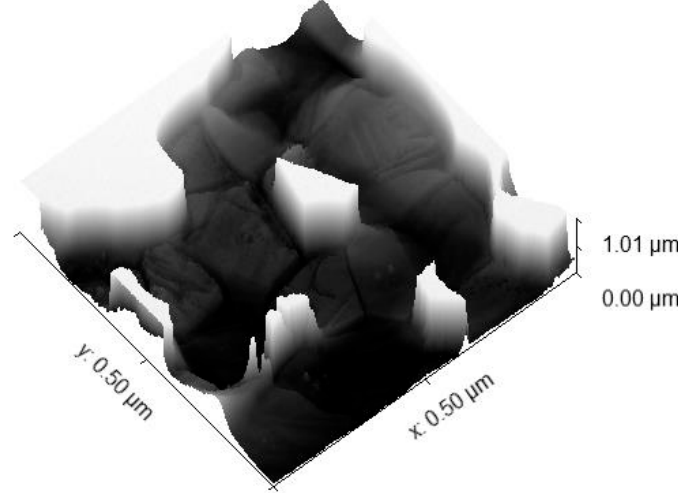
Figure 1. Grains surface reconstruction based on scanning electron microscopy (SEM) and scanning transmission electron microscopy (STEM) microstructure characterization under 60 k times magnification.